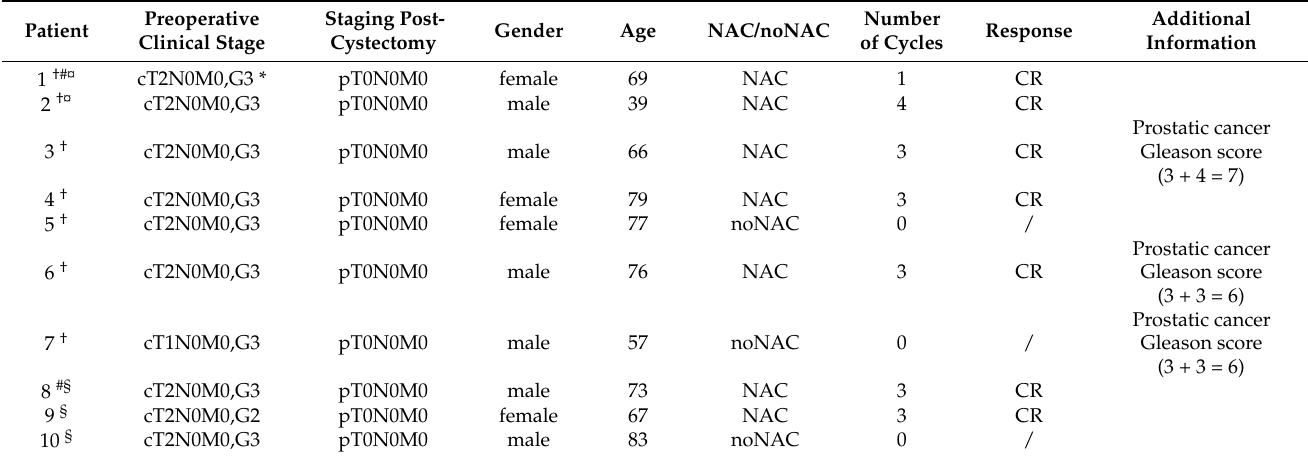
Table 1. Patient